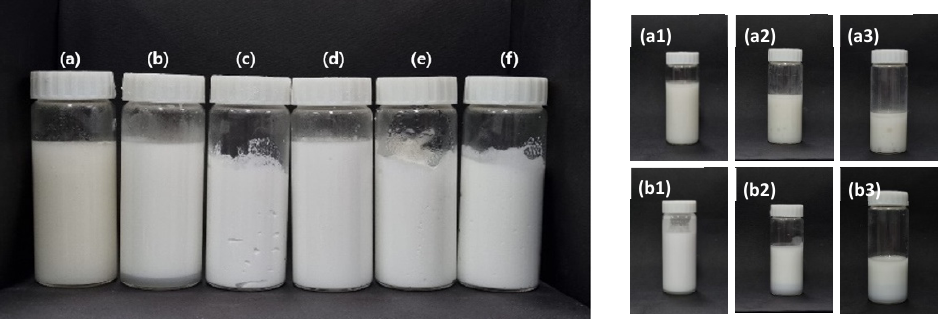
Figure 6. (Left) Emulsions prepared with gelling agents after 1 cycle of harsh treatment: ( a ) Xanthan gum (1.0 wt%), ( b ) Carbopol 981 (1.0 wt%). ( c ) TR-2 (0.5 wt%), ( d ) TR-2 (0.5 wt%), ( e ) Ultrez 20 (0.5 wt%), and ( f ) Ultrez 20 (0.25 wt%). (Right) Emulsions prepared with gelling agents in harsh environment: ( a1 – a3 ) Xanthan gum (1.0 wt%) and ( b1 – b3 ) Carbopol 981 (1.0 wt%) after 1, 3, and 5 cycles of harsh testing.